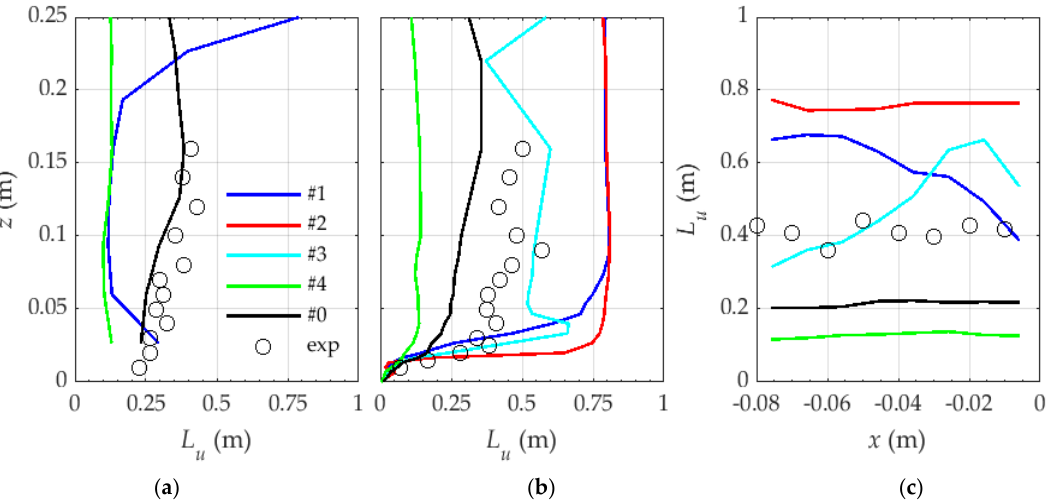
Figure 11. Integral length scale of turbulence at the rooftop of the Muirhead tower ( a ) and Biosciences building ( b , c ).